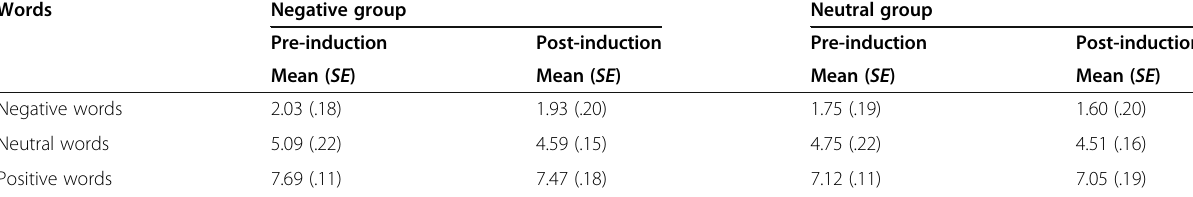
Table 3 The mean scores of participants for the evaluation of words in each group